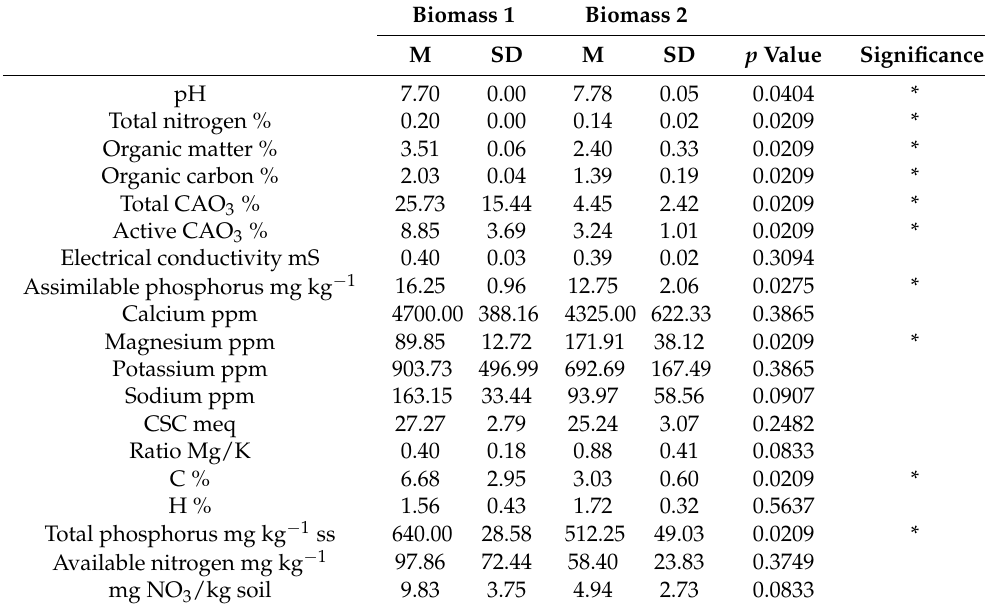
Table 1. Mean results of physical–chemical soil analyses. Standard deviation, p -value ( α = 0.05), and significance are shown. The * indicates a statistically significant difference.